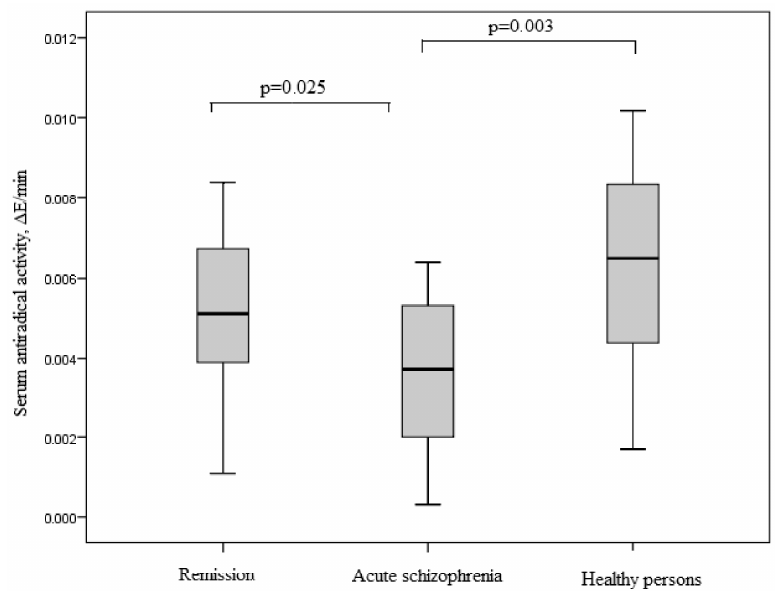
Figure 6. TAC of blood serum in patients with acute schizophrenia, remission, and healthy persons. Note: ∆ E/min—change in the optical density of the solution per minute.